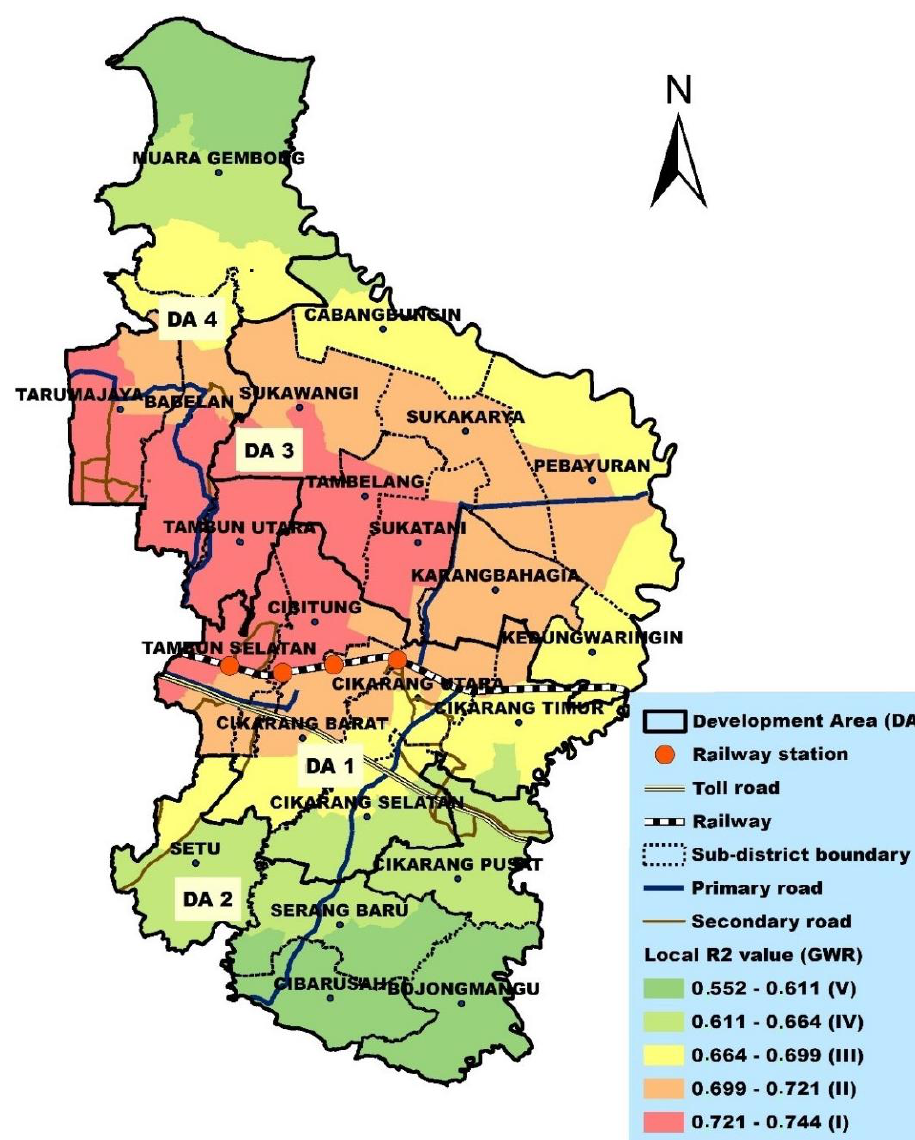
Figure 3. Local R 2 value of GWR analysis results for each desa/kelurahan in